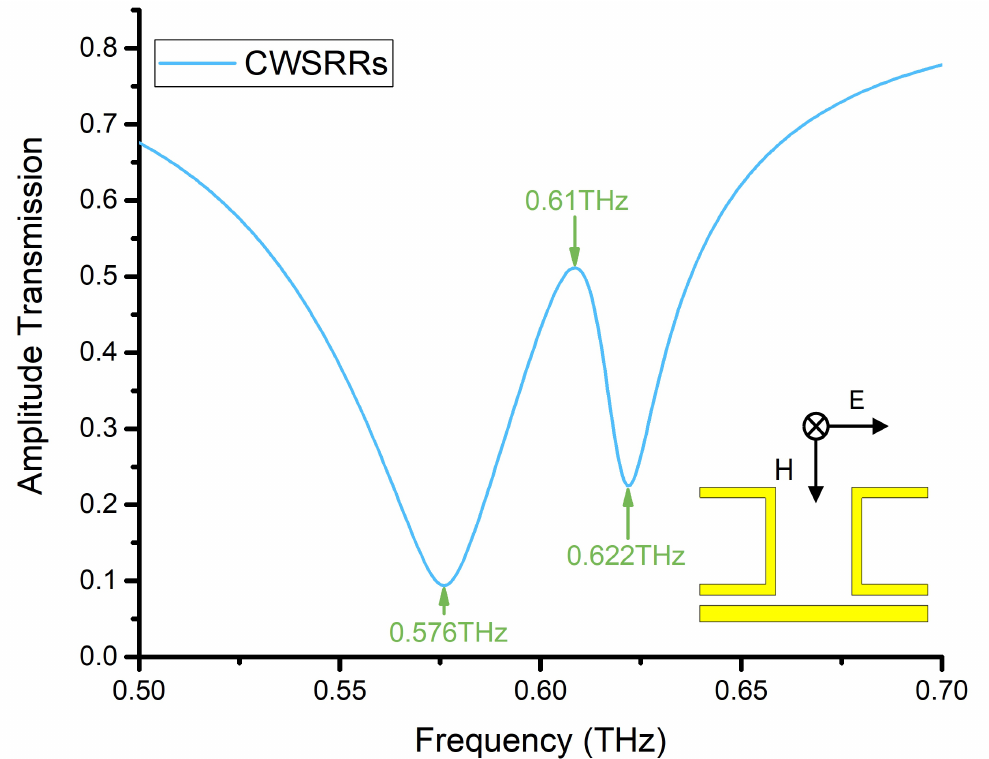
Figure 4. Simulated amplitude transmission of